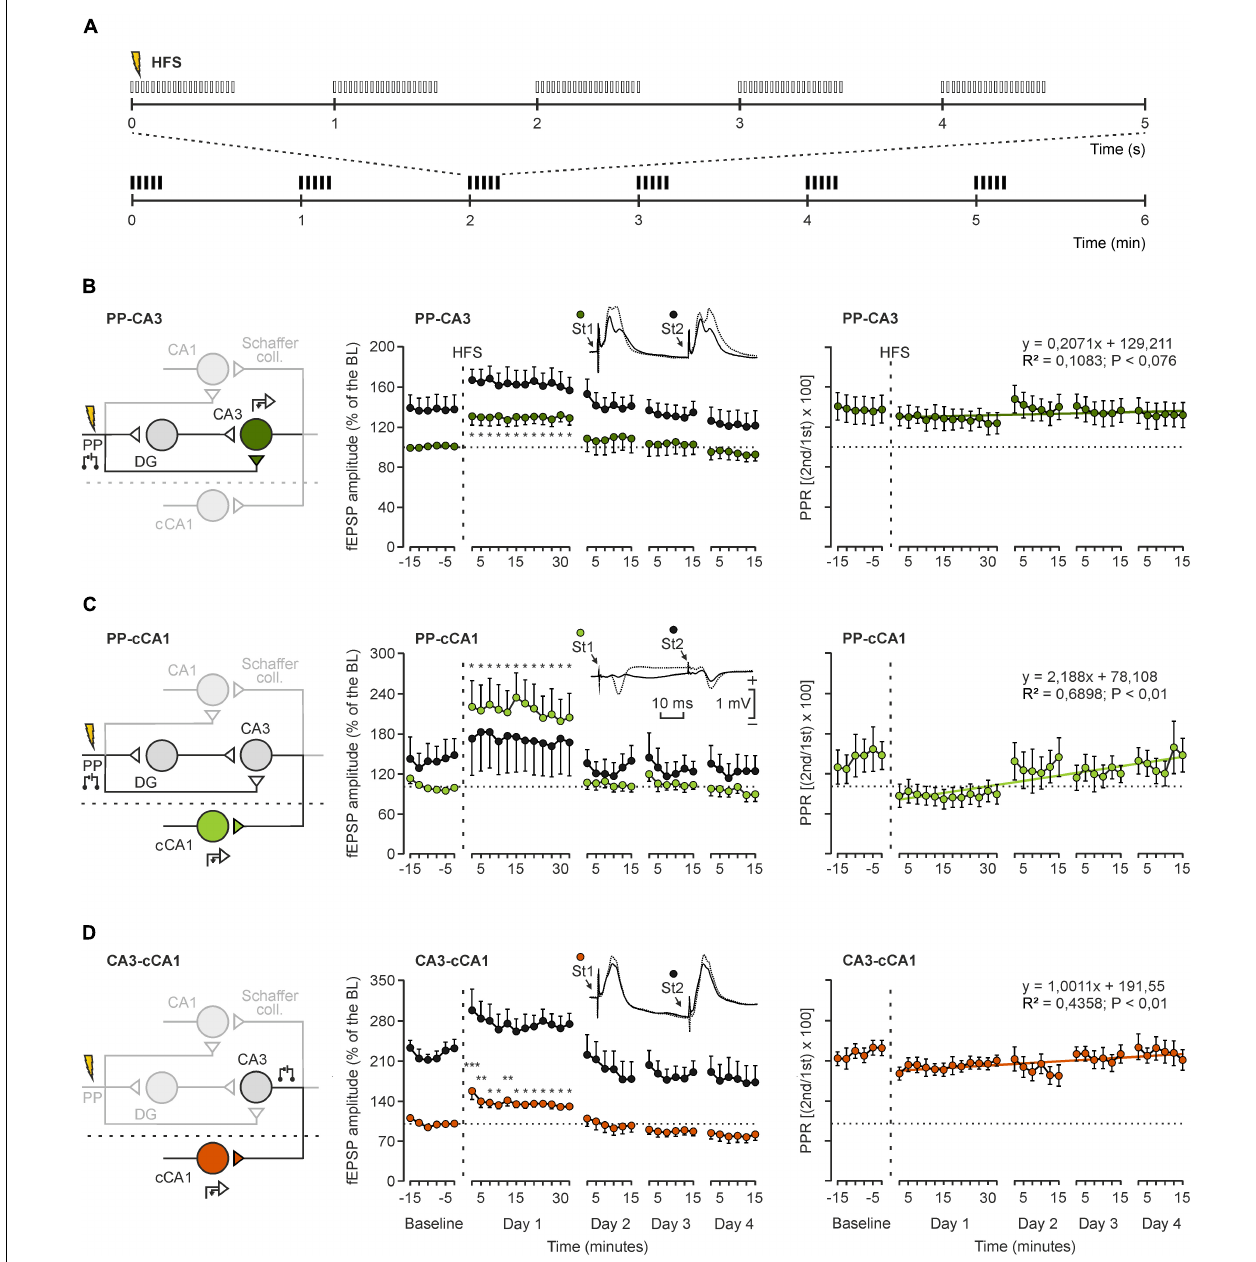
FIGURE 4 | High-frequency stimulation of the PP evoked LTP in CA3 and cCA1. (A) The high-frequency stimulation (HFS) protocol consisted of 5 trains (200 Hz, 100 ms) of pulses at a rate of 1/s. These trains were presented 6 times in total, at intervals of 1/min. (B–D) Schematic representation of the stimulating and recording sites during the experiment (left), LTP evolution of PP-CA3 (B) , PP-cCA1 (C) and CA3-cCA1 (D) synapses (middle) and their paired-pulse ratios and linear regression lines (right). Insets illustrate representative examples of recorded fEPSPs from the three indicated synapses –not necessarily from the same mouse. Each circle represents the average amplitude computed from 15 stimulus presentations ± SEM. LTP was evoked in the 3 synapses by HFS of the PP. In order to obtain a baseline, animals were stimulated every 10 s for 15 min in the afferent pathway. After HFS, the same stimulus was presented at the initial rate (6/min) for another 30 min. Recording sessions were repeated on 3 additional days (15 min each) ( n = 10). * P < 0.05; ** P < 0.01; *** P < 0.001 (one-way ANOVA, contrast analysis against baseline